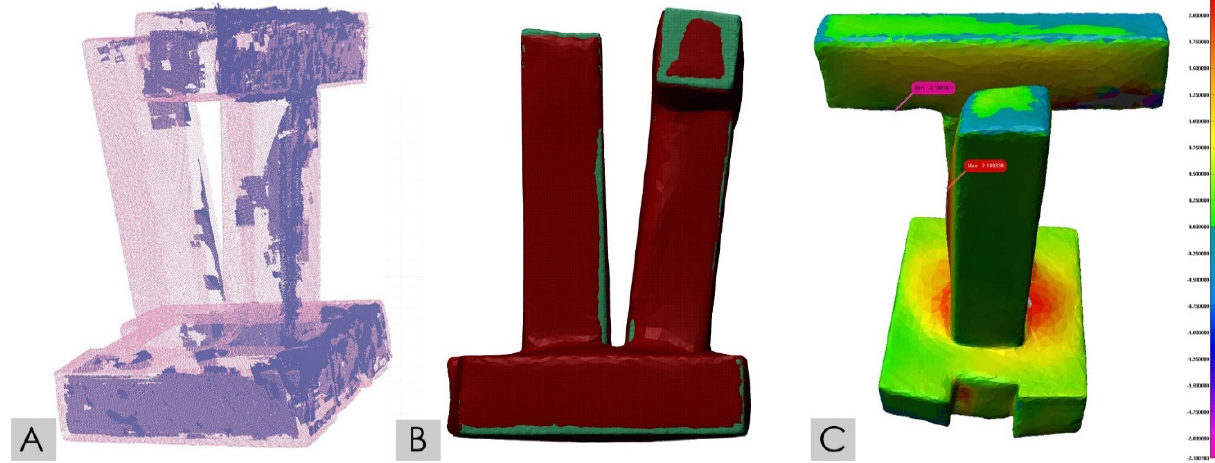
Figure 6. A: overlapping point clouds obtained from Shape from Stereo method (darker) versus laser scanner data (lighter). B: overlapping meshes obtained from Shape from Silhouette (in red) versus laser scanner data mesh (in green). C: error scale